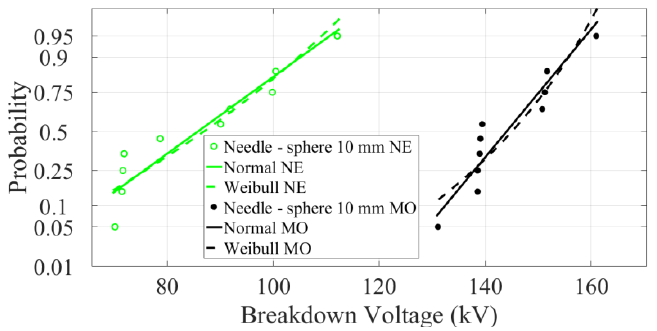
Figure 5. Weibull and normal distribution for natural ester liquid and mineral oil at 10 mm gap distance fitted to the measured needle—sphere data at negative polarity.